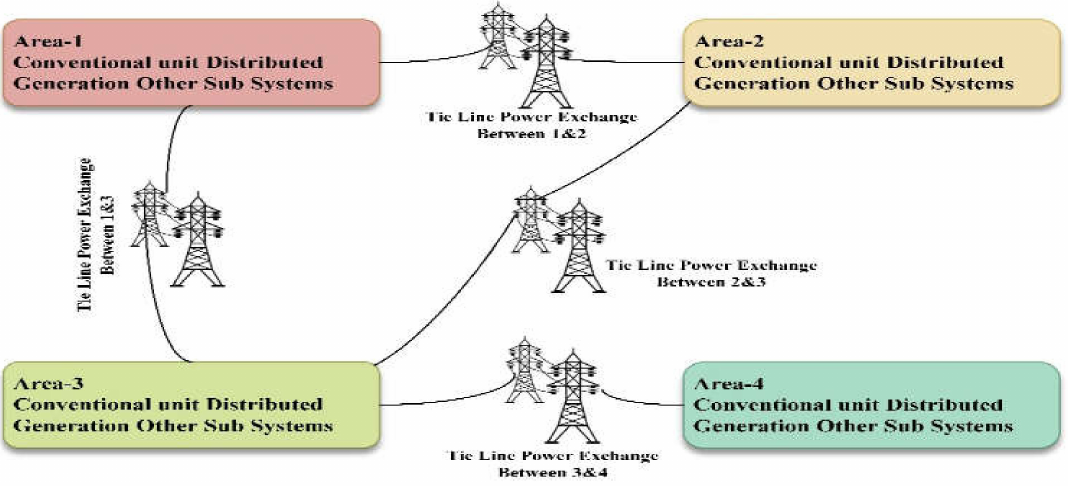
Figure 4. Power Exchange between Different